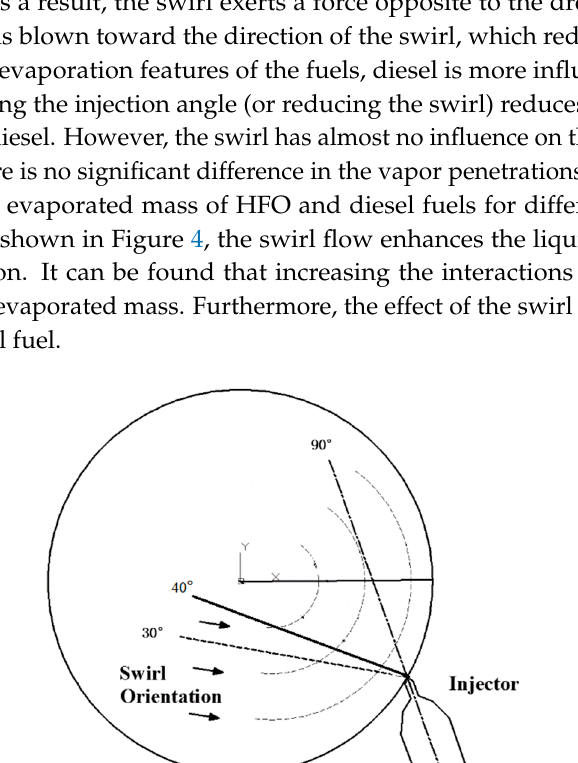
Figure 4. Comparison of spray configurations under different spray orientations at 9 MPa of ambient pressure at 3 ms after start of injection. ( a ) Liquid penetrations; ( b ) Vapor penetrations.